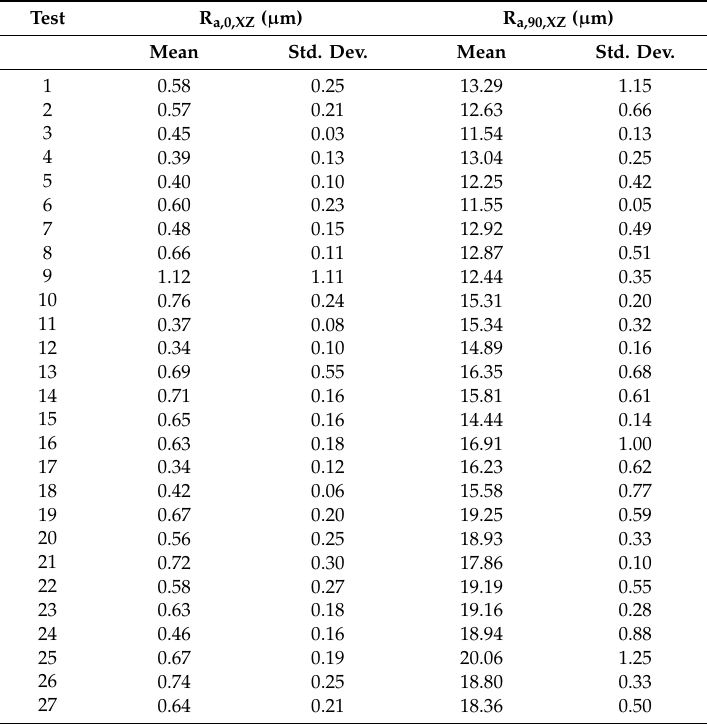
Table 6. Mean and standard deviation of surface roughness for XZ